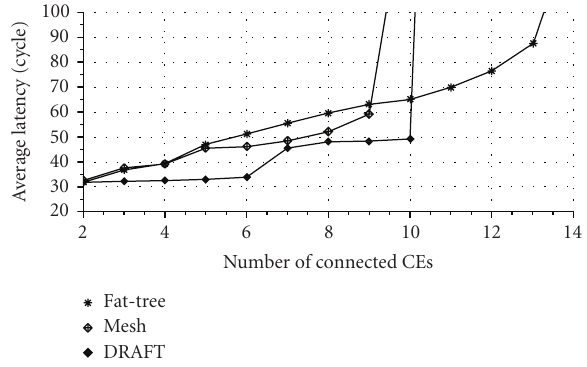
Figure 14: Comparison of the average latencies depending on the number of simultaneously connected CEs.